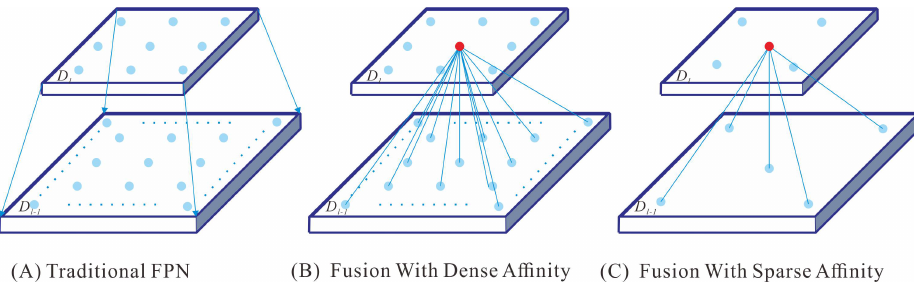
Figure 3. Schematic diagram of three types of feature fusion structures. ( A ) The FPN, where the top feature is directly propagated by the addition function. ( B ) The recent feature fusion structure with a dense affinity function, where the top feature is propagated by calculating the affinity on two adjacent layers. ( C ) The sparse affinity function, which only calculates the affinity of representative features.